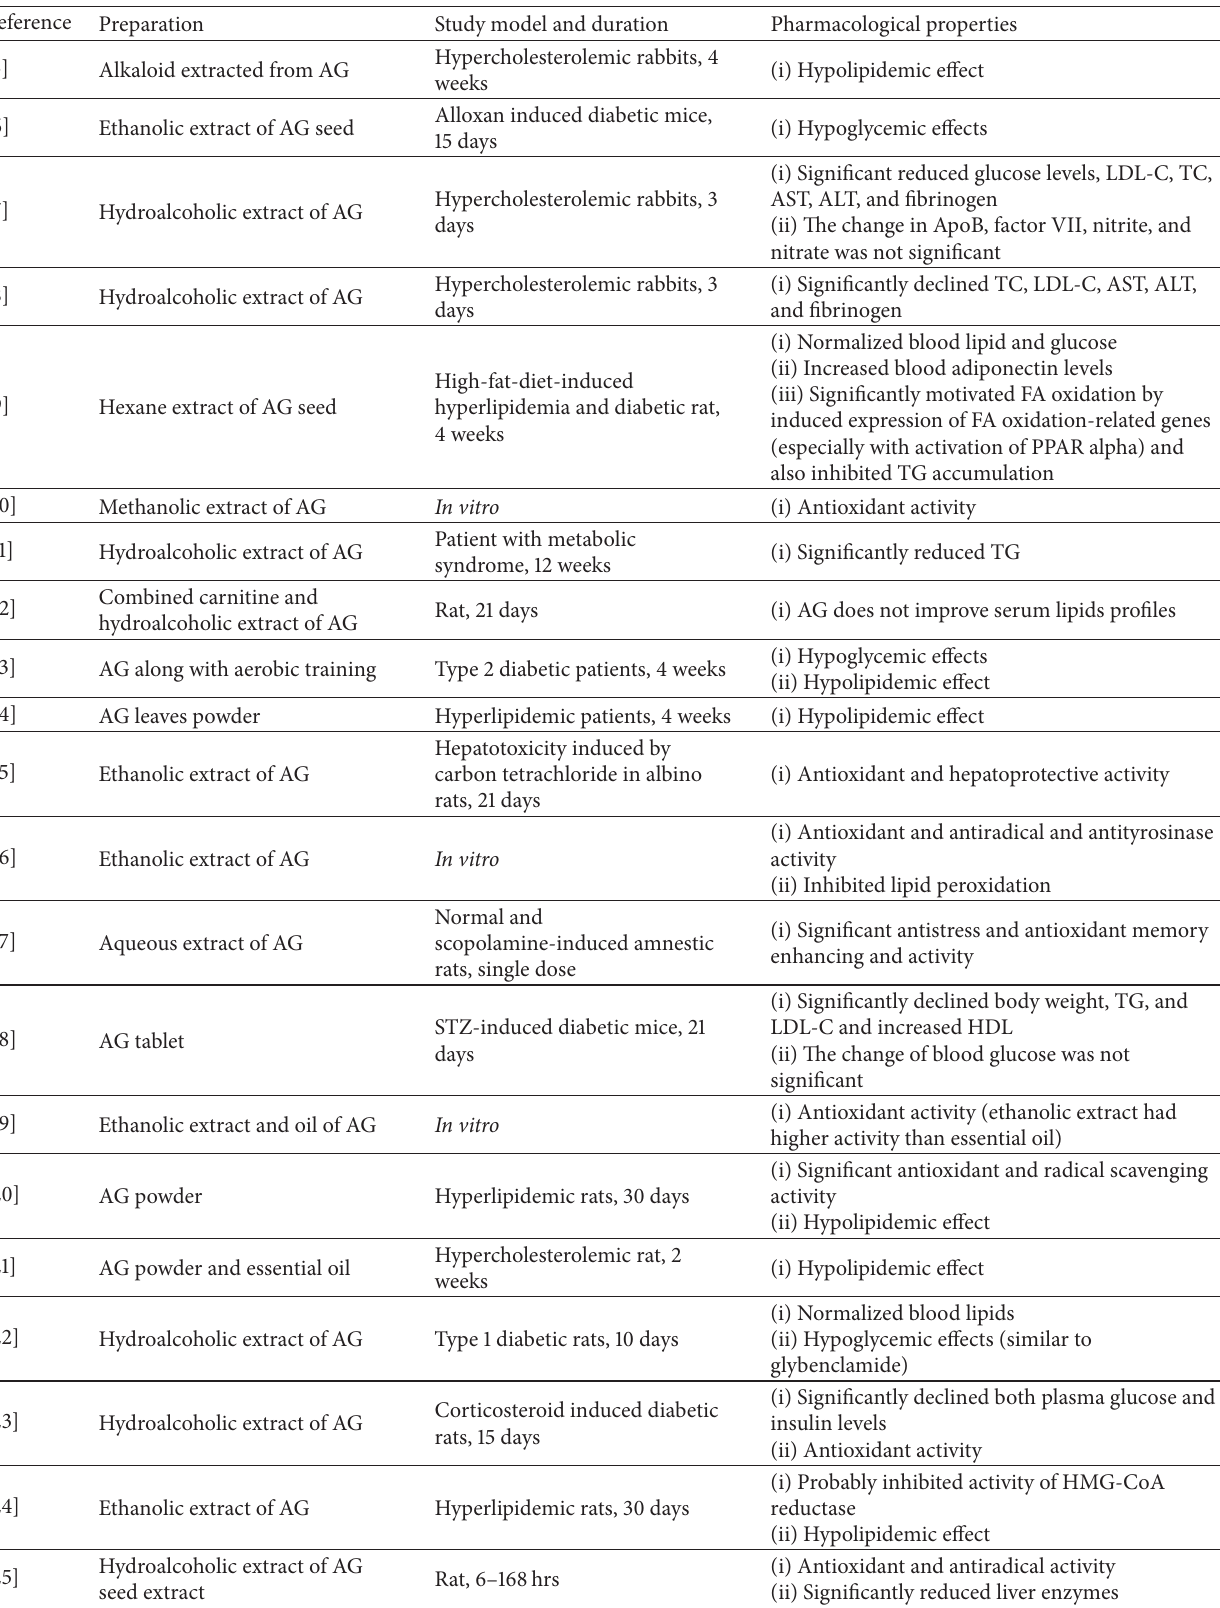
Table 1: Antidiabetic effects of AG in different